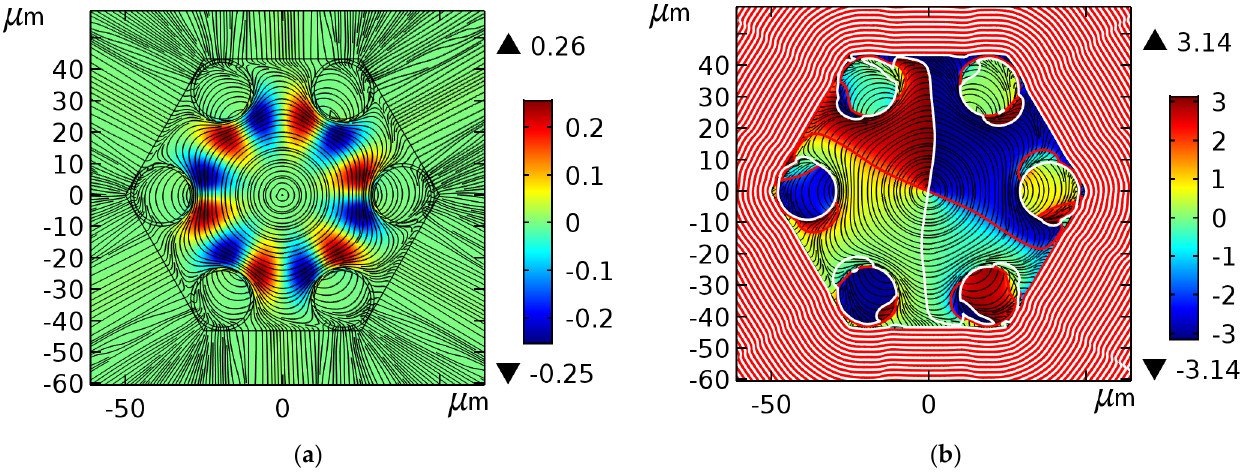
Figure 7. Hollow core waveguides formed by six capillaries with an outer diameter of 20 µ m and a wall thickness of 1 µ m inserted into the corners of the hollow core hexagon (Figure 2b): ( a ) radial projection of the transverse component of the Poynting vector of the fundamental air core mode at a wavelength of 3.39 µ m; ( b ) phase distribution of the axial electric field component of the fundamental air core mode at a wavelength of 3.39 µ m. Thin red and white lines correspond to the condition that the real (red) and imaginary (white) parts of the axial component of the electric field being equal to zero. The phase changes from − π (dark blue) to π (dark red). The refractive index of the capillaries is 1.45.